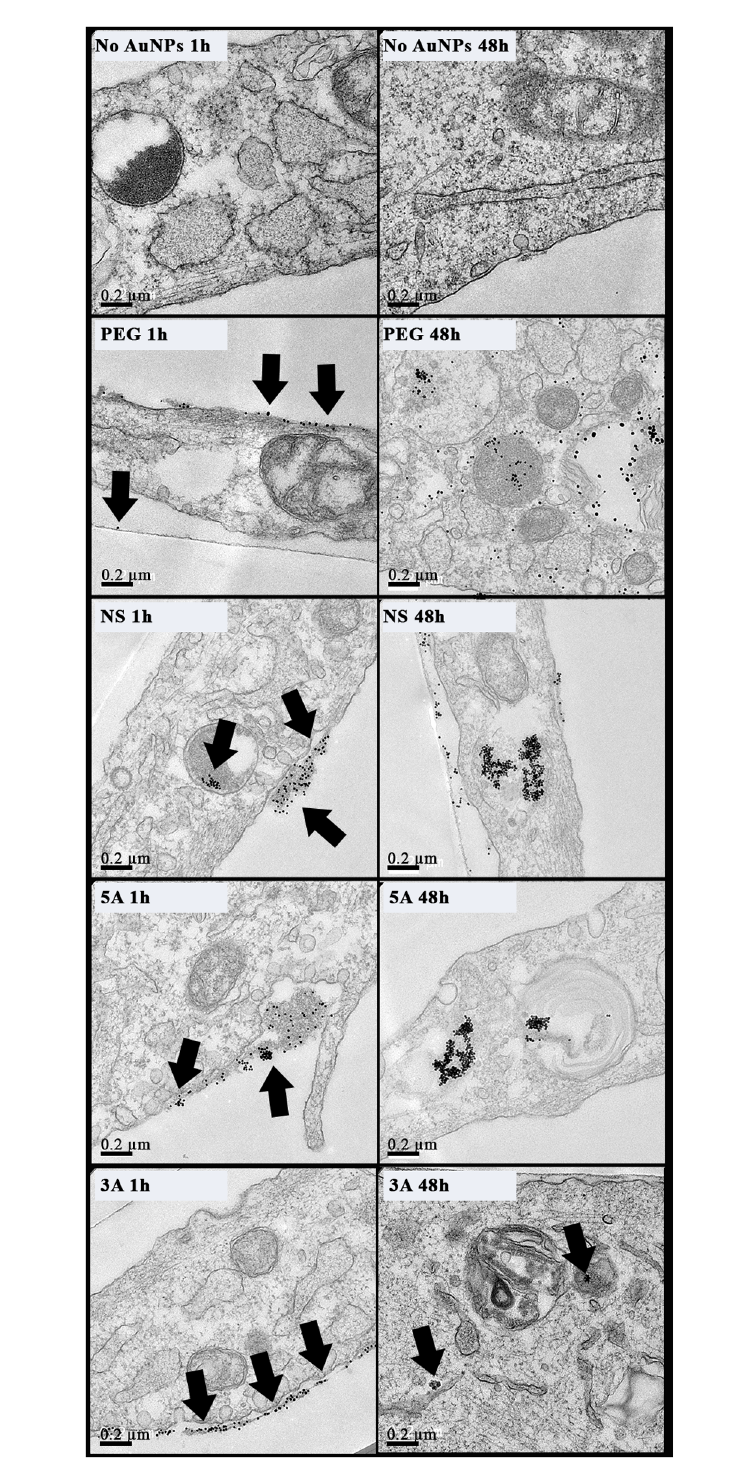
Fig 4. TEM images of MSCs cells treated with GNPs (50nM, 30%) for 1 and 48 hours. Arrows indicate GNP clusters (n = 3 technical replicates; scale bar = 0.2μm).